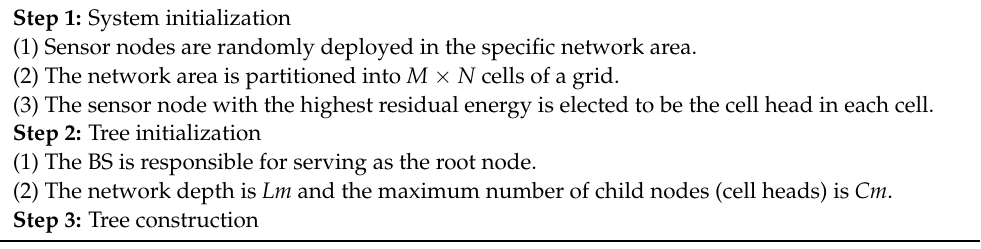
Algorithm 1: The tree-like path establishment algorithm of LB-TBDAS.